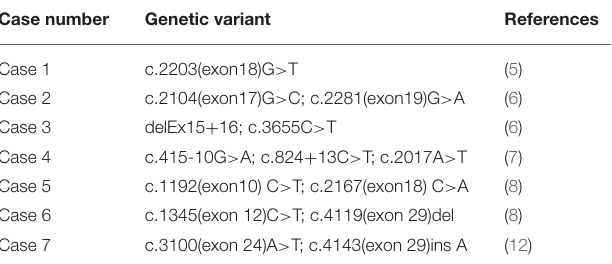
TABLE 4 | Mutation analysis of the ADAMTS13 in neonatal patients with congenital